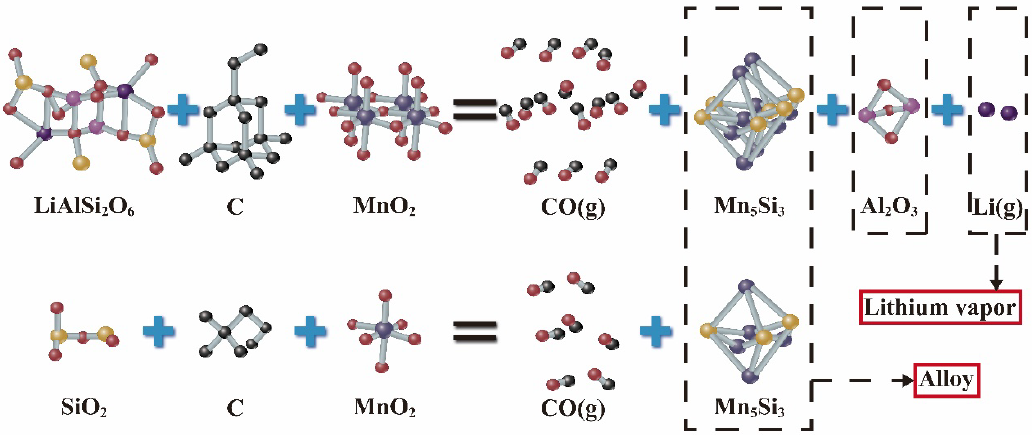
Figure 15. Reaction mechanism diagram.